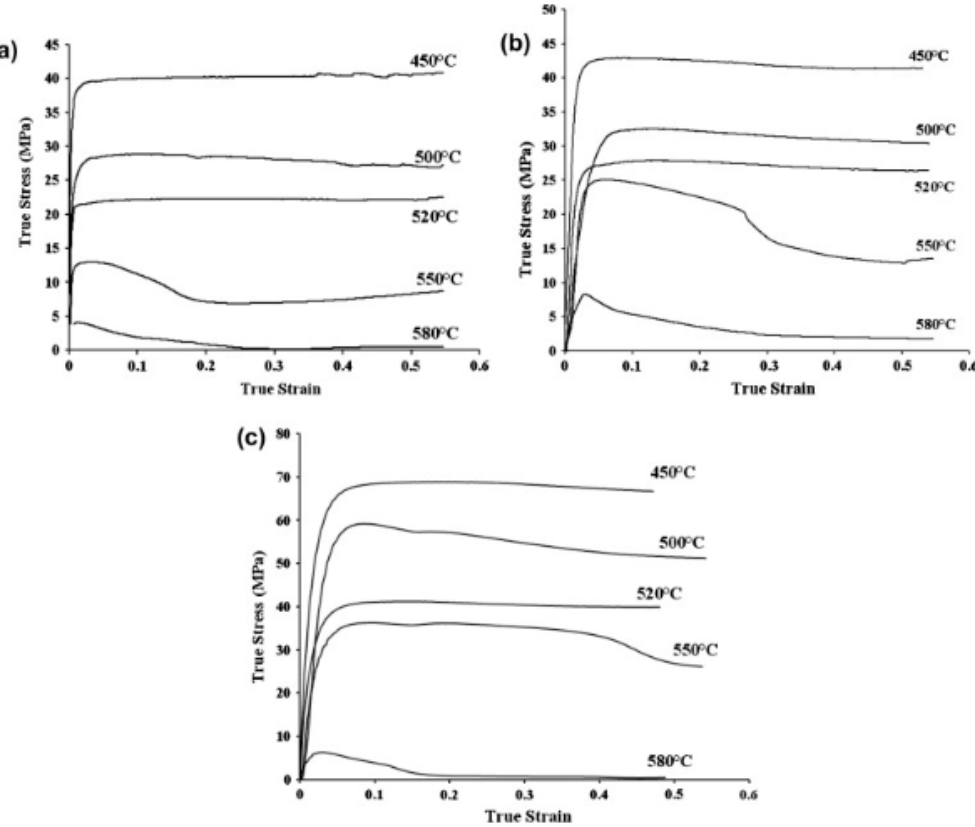
Figure 13. The true stress–true strain curves of the experimental alloy during hot compression at various temperatures and different strain rates of ( a ) 0.004 s − 1 ; ( b ) 0.04 s − 1 and ( c ) 0.4 s − 1 (the figure is reproduced from [91], with permission from the Elsevier, 2016).